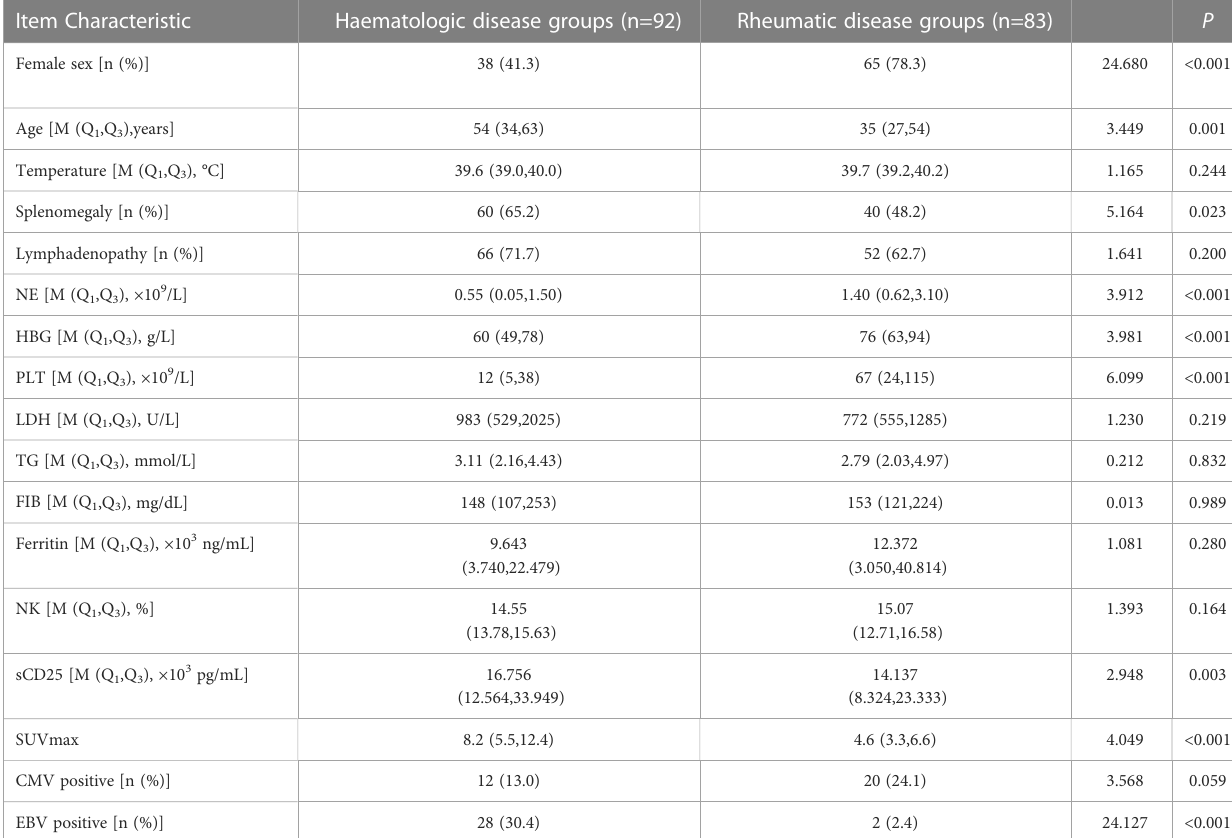
TABLE 3 The comparison of clinical characteristics between patients with rheumatic and haematologic disease-related HLH, in terms of value (range).